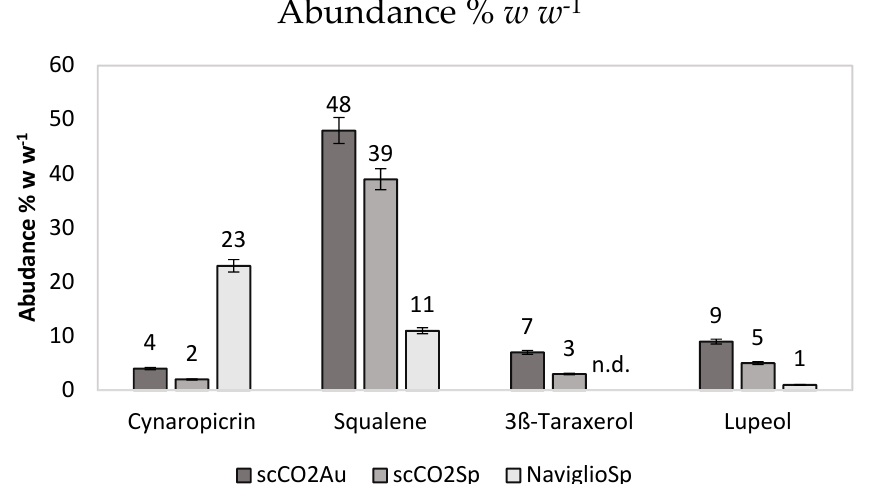
Figure 2. Abundance % w w − 1 of each bioactive molecule measured by GC-MS. Data are the results of triplicated analysis and standard deviations are reported.